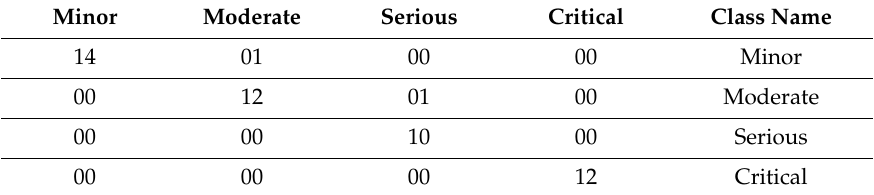
Table 10. Confusion Matrix for fold 3.